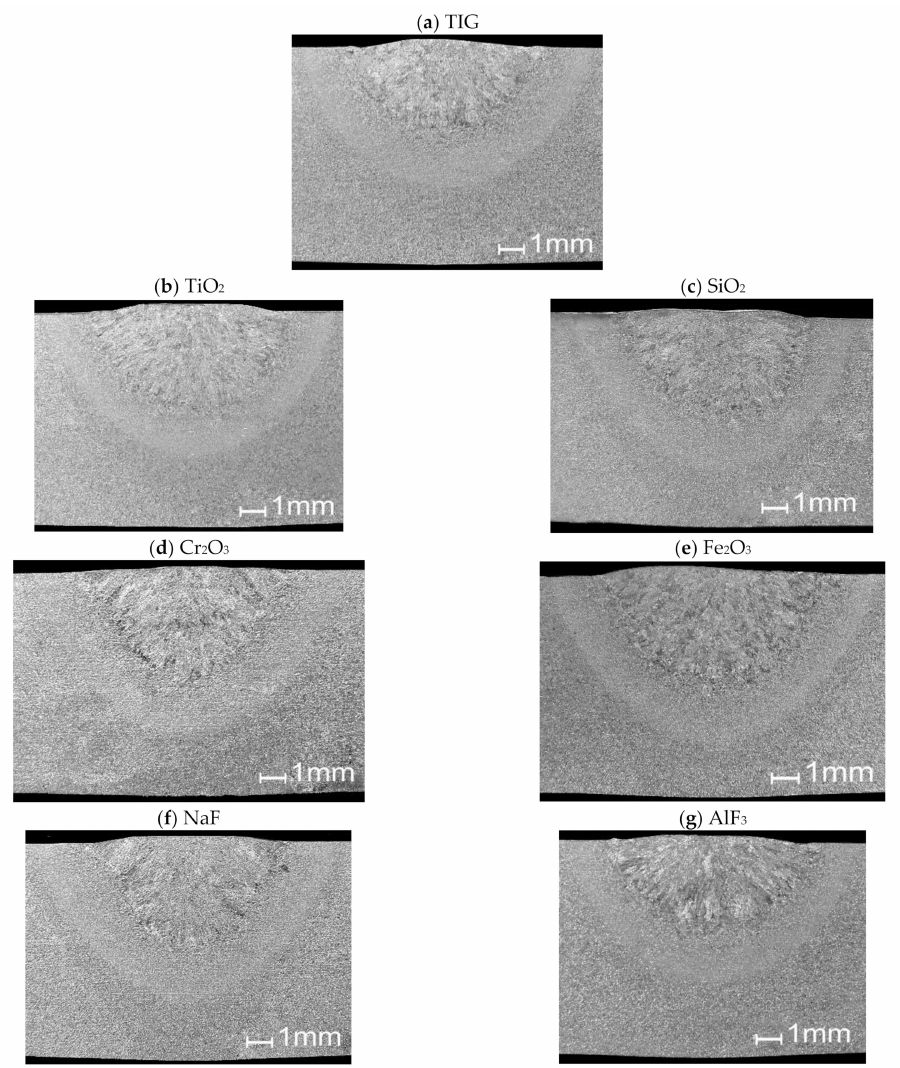
Figure 4. Macrostructure of the welds made on boiler steel P265GH using ( a ) conventional TIG without flux and A-TIG with various fluxes: ( b ) TiO 2 ( c ) SiO 2 ( d ) Cr 2 O 3 ( e ) Fe 2 O 3 ( f ) NaF ( g ) AlF 3